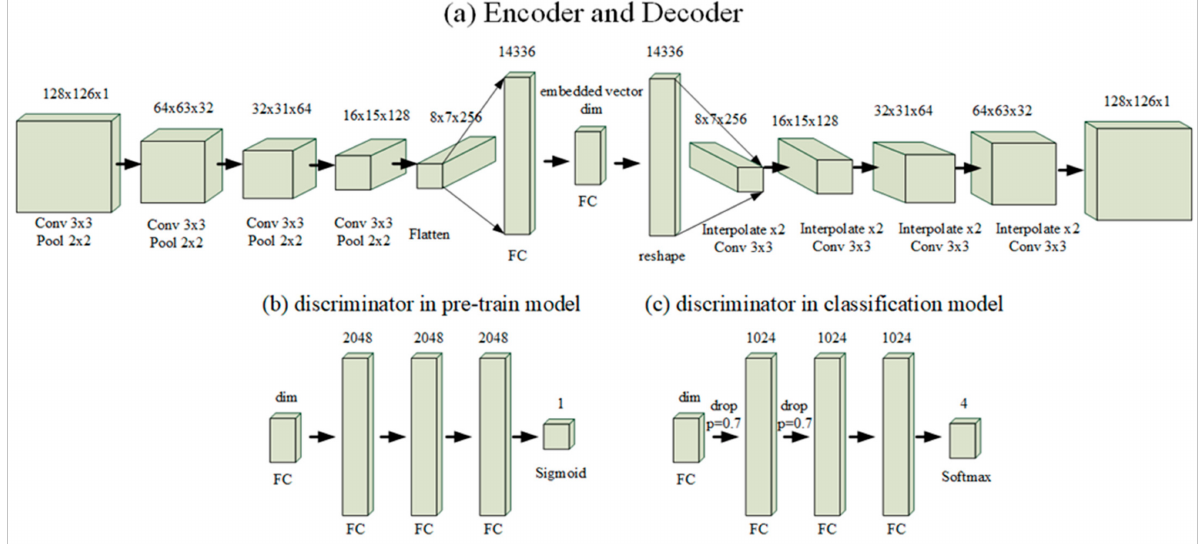
Figure 5. Scheme of the encoder, decoder and discriminator models. FC: fully connected layer. ( a ) The architecture of encoder and decoder model; ( b ) the discriminator in pre-train model; ( c ) the discriminator in classification